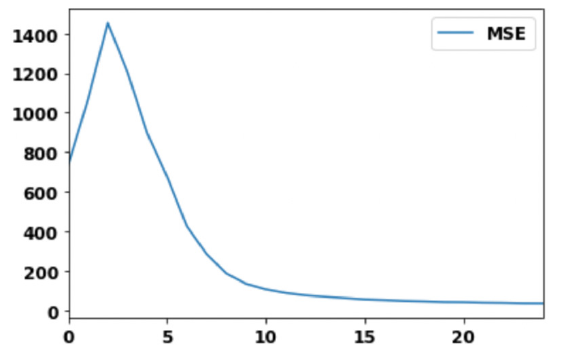
Figure 5. MSE through 25 training epochs of the proposed M-CRBMs that take three types of extra information in the conditional